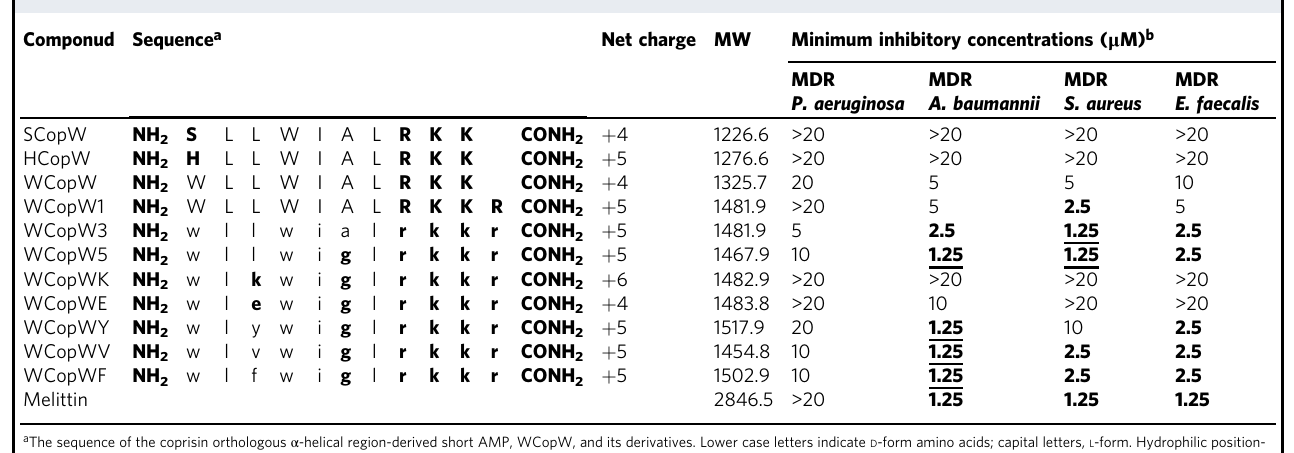
(Table 2). The placement of Trp3 in the mid-membrane part of an AMP may be preferred by an adjacent interfacial slab, as observed in the toroidal-pore AMP model (Supplementary Fig. 1).